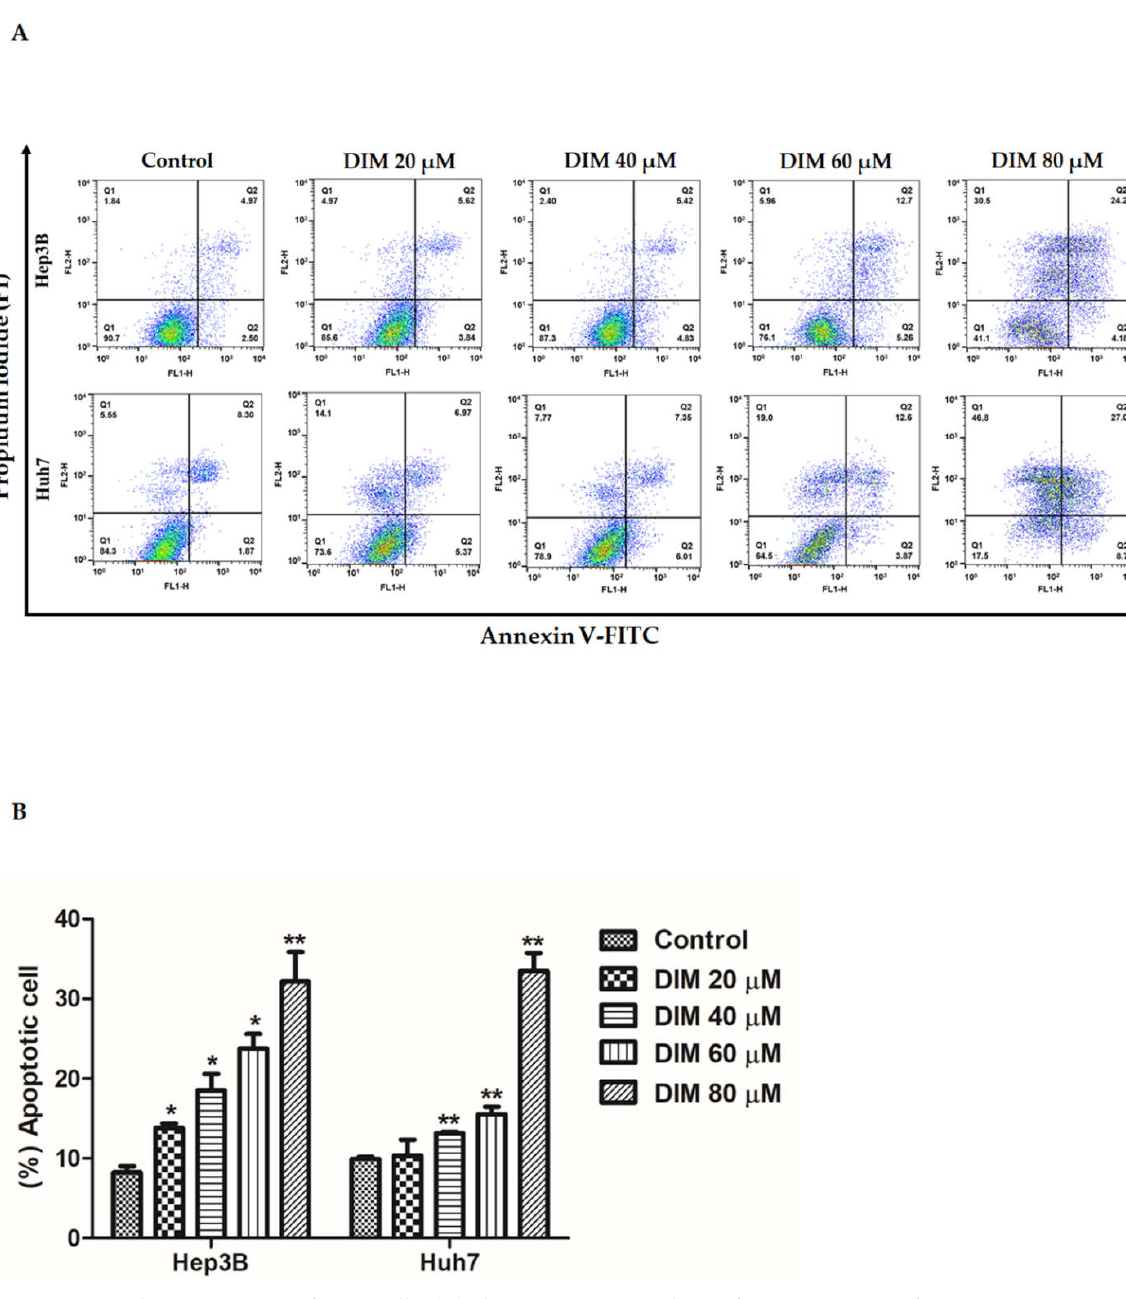
Figure 3. DIM induces apoptosis of HCC cells. ( A ) Flow cytometric analysis of Annexin V-FITC/PI staining in Hep3B and Huh cells after treatment with DIM (0, 20, 40, 60, and 80 µM) for 24 h. ( B ) Bar graphs representing quantitative assessment ( % ) of cell death induced by DIM in Hep3B and Huh7 cells. Data are presented as mean ± SE of three independent experiments. *, p < 0.05 and **, p < 0.01 denote significant difference compared to the untreated control.